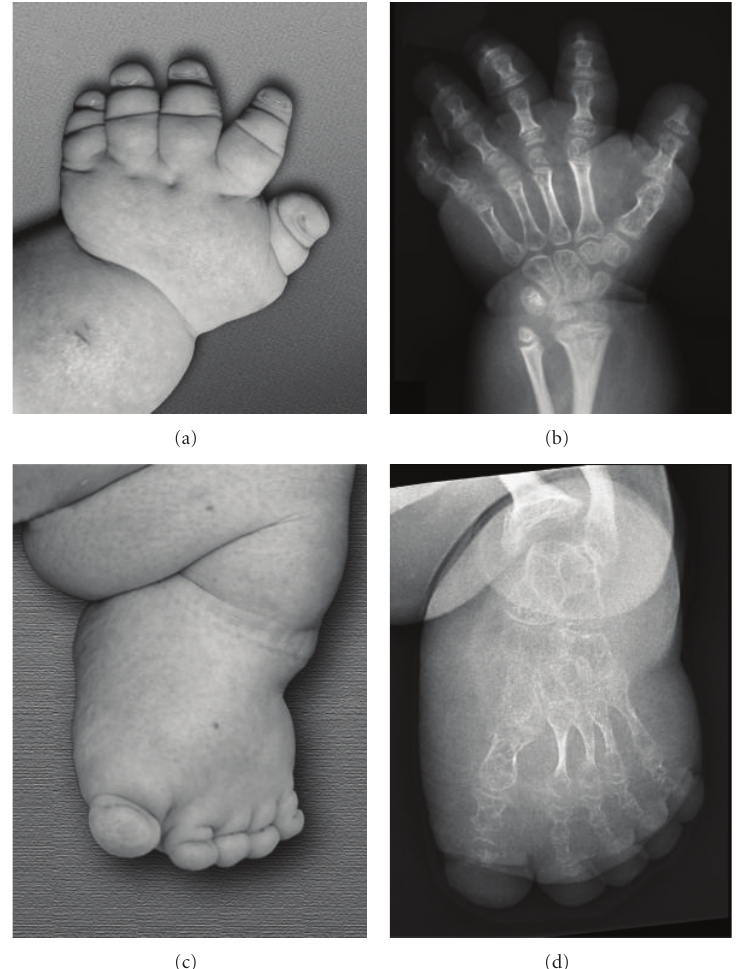
Figure 9: Radiographs of hands and feet in a 15-year-old female. Small stubby hands and feet with hypoplastic nails (a, c). Severe shortening and thinning of all tubular bones including metacarpal and metatarsal bones, especially marked at the distal phalanges (b, d), adapted with modification from